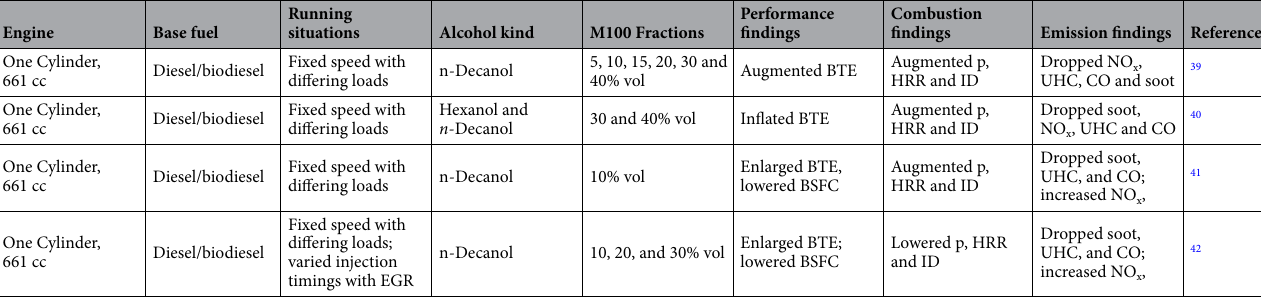
Table 1. Combustion and emission characteristics of CI engines driven by n-decanol/diesel/biodiesel